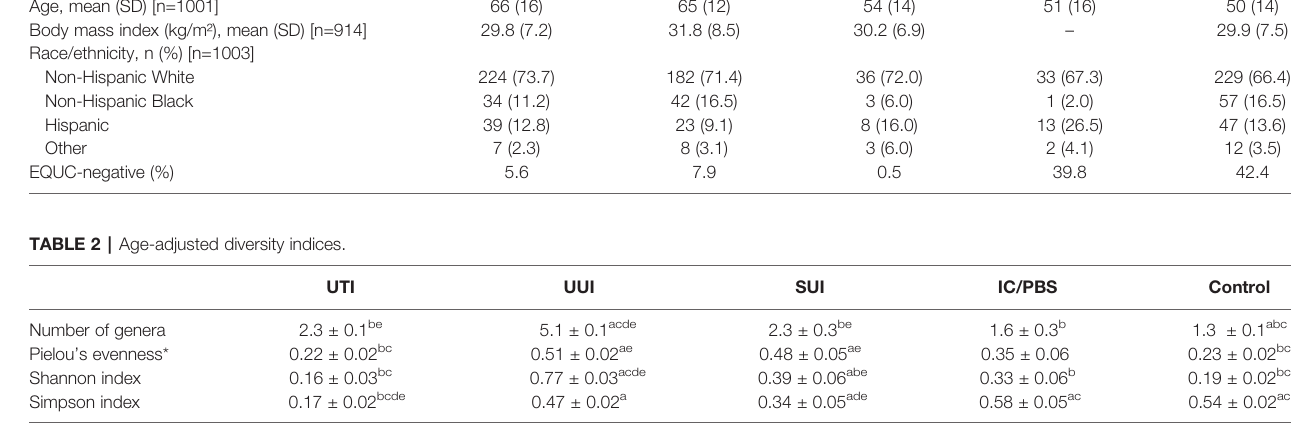
( Table 2 ). Correlations of age and body mass index with diversity indices were small to moderate across cohorts ( Supplemental Table 2 ). Older age was associated with higher diversity indices in